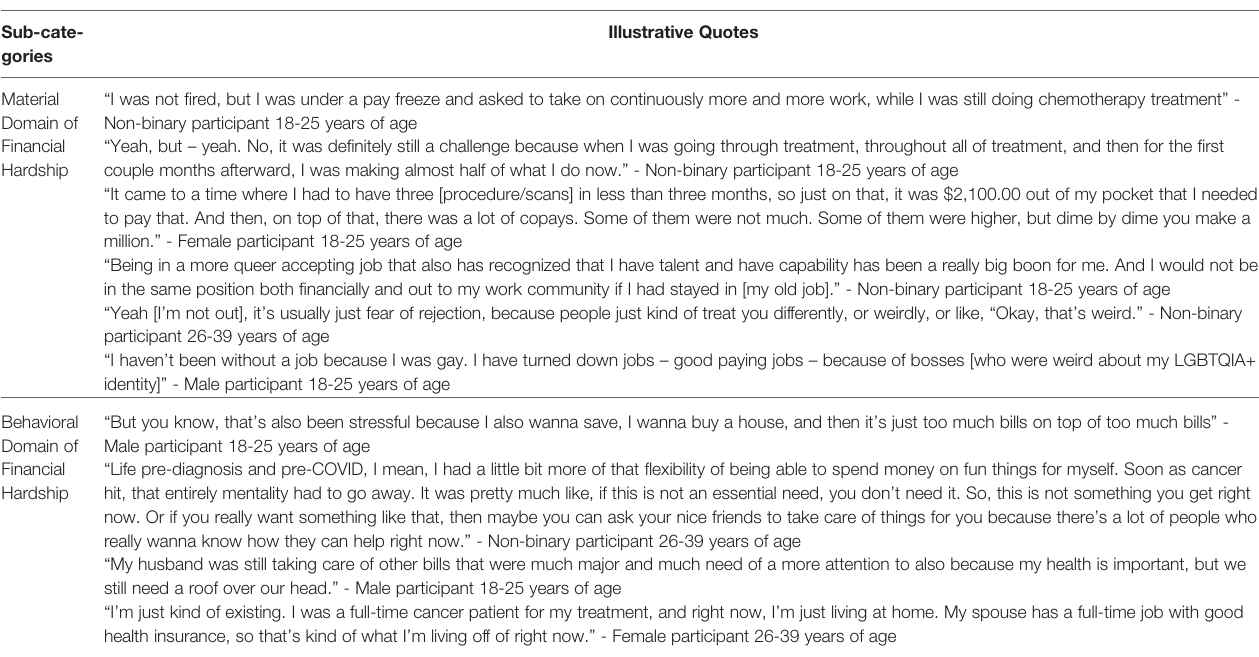
TABLE 2 | Material and Behavioral Financial Hardship – Sub-categories and Illustrative